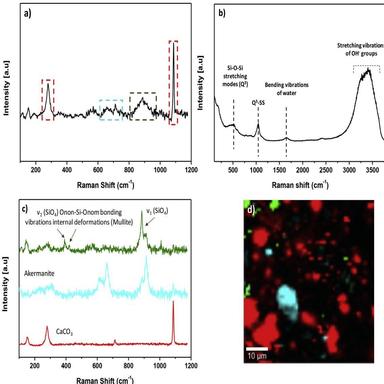
a) Average Raman spectrum of the anhydrous blast furnace slag; b) Average Raman spectrum of sodium silicate solution (waterglass solution); c) average Raman spectra of the main phases present in the anhydrous blast furnace slag: calcium carbonate (CaCO3 in red), akermanite (Ca2Mg(Si2O7), in cyan) and the symmetric stretching bonds of SiO4 from slag, in green; d) Surface Raman image (60 × 60 μm2 , integration time of 1.0 s and 60 × 60 pixels) by CRM of the anhydrous blast furnace slag used in this study. The